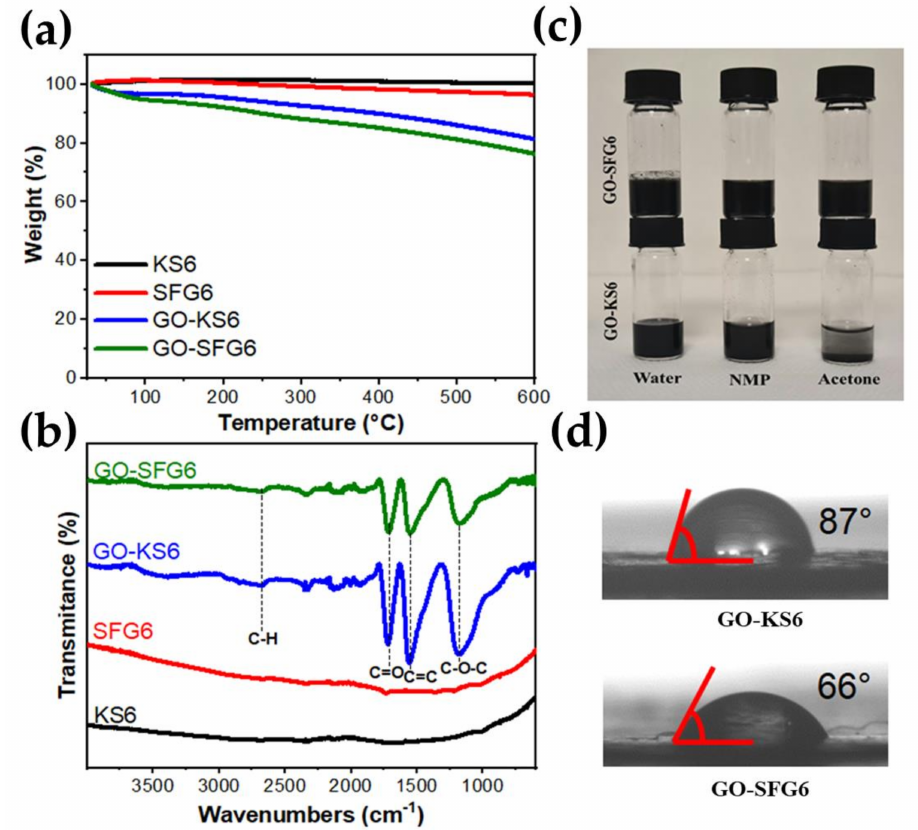
Figure 3. ( a ) The TGA profiles of all samples. ( b ) The FTIR specters of all samples. ( c ) The dig- ital pictures of the GOs dispersions in various solvents. ( d ) The digital pictures of contact angle measurements of water in GO-KS6 and GO-SFG6